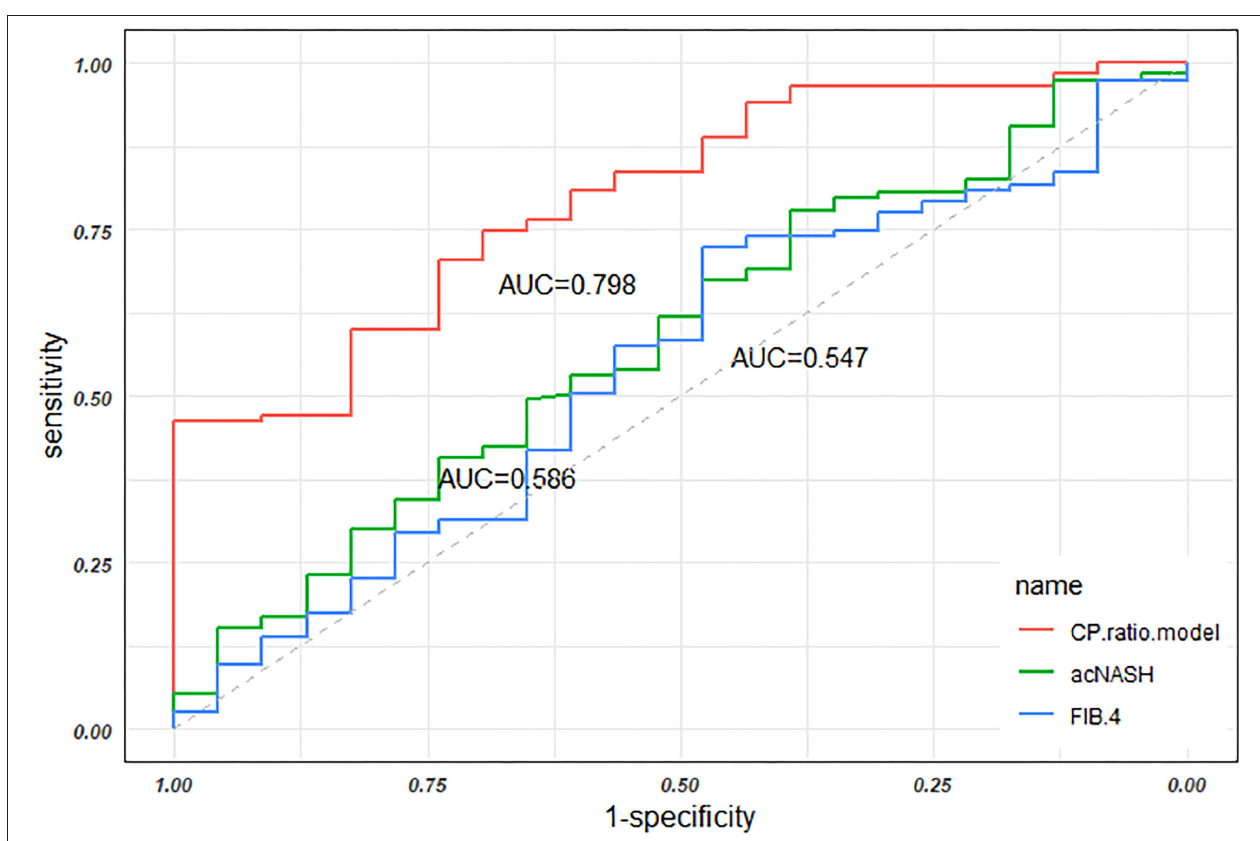
FIGURE 5 | The AUCs of the CP ratio model, the acNASH index, and FIB-4 in discriminating NASH in the overall groups. Abbreviations: AUC, area under the receiver operator characteristic curve; CP, ceruloplasmin; NASH, nonalcoholic steatohepatitis; ROC, receiver operator characteristic